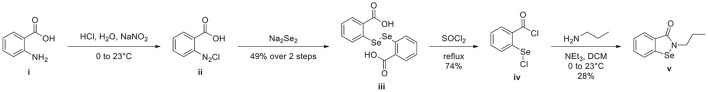
Synthesis of 2-propylbenzo[d][1,2]selenazol-3(2H)one v from anthranilic acid i. 2-propylbenzo[d][1,2]selenazol-3(2H)one v was prepared in 4 steps from inexpensive, commercially available anthranilic acid i. Anthranilic acid i was diazotized to afford diazonium salt ii, which was treated in situ with sodium diselenide, yielding 2,2′-diselanediyldibenzoic acid iii. Refluxing iii in thionyl chloride gave 2-(chlorocarbonyl)phenyl hypochloroselenoite iv. The synthesis concluded by treating iv with 1-aminopropane, which, after addition-elimination and substitution, yielded 2-propylbenzo[d][1,2]selenazol-3(2H)one v.